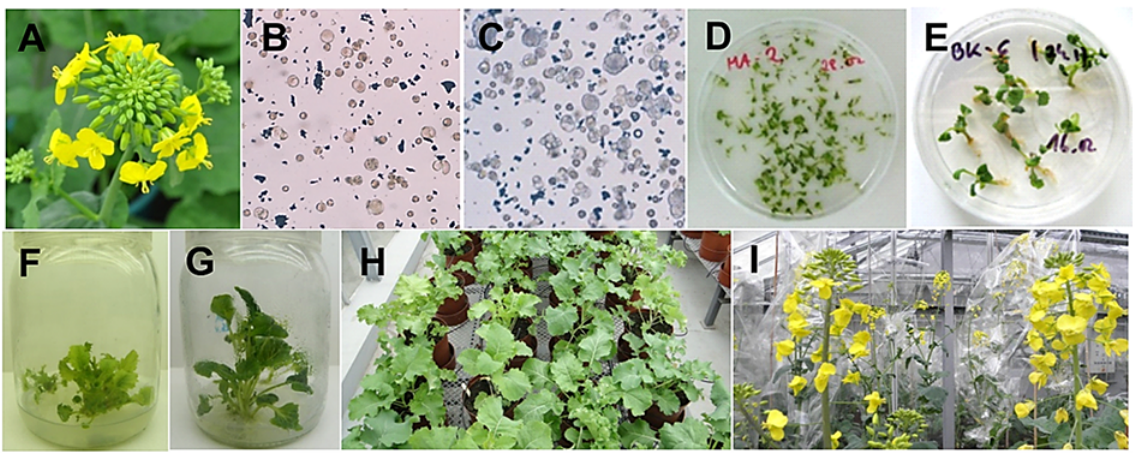
Figure 6 Stages of doubled haploid production of oilseed rape ( Brassica napus L.) through isolated microspore culture. ( A ) Inflorescence of donor plant at the stage optimal for isolation of microspores. ( B ) ree days of isolated microspore culture – first microspore divisions. ( C ) Microspore-derived embryos (MDEs) aer 10 days of in vitro culture. ( D ) MDEs aer 3 weeks of in vitro culture. ( E ) Apical shoot development – 5–6 weeks of in vitro culture. ( F ) Shoot regeneration. ( G ) Plant rooting. ( H ) Androgenic plants transferred to soil aer vernalization. ( I ) Flowering plants in a greenhouse. Photographs from the archives of the Department of Oilseed Crops, Plant Breeding and Acclimatization Institute – National Research